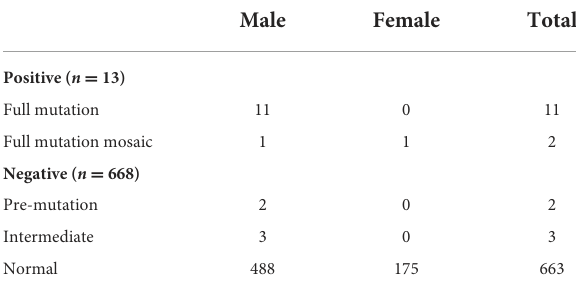
TABLE 2 Results of fragile X testing among unexplained etiology ID/GDD